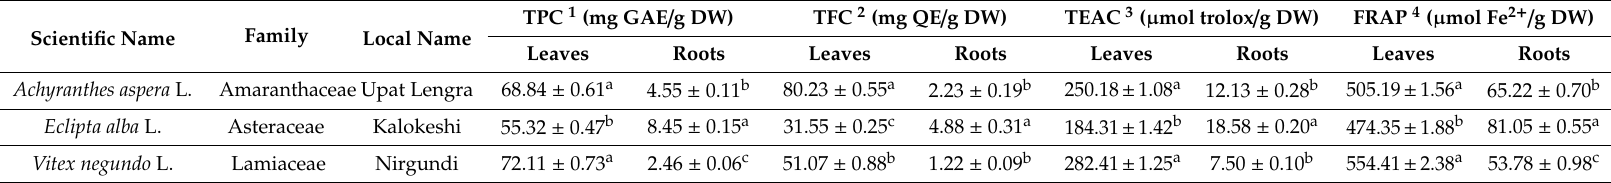
Table 2. Total phenolic, flavonoid, TEAC, and FRAP contents of the selected